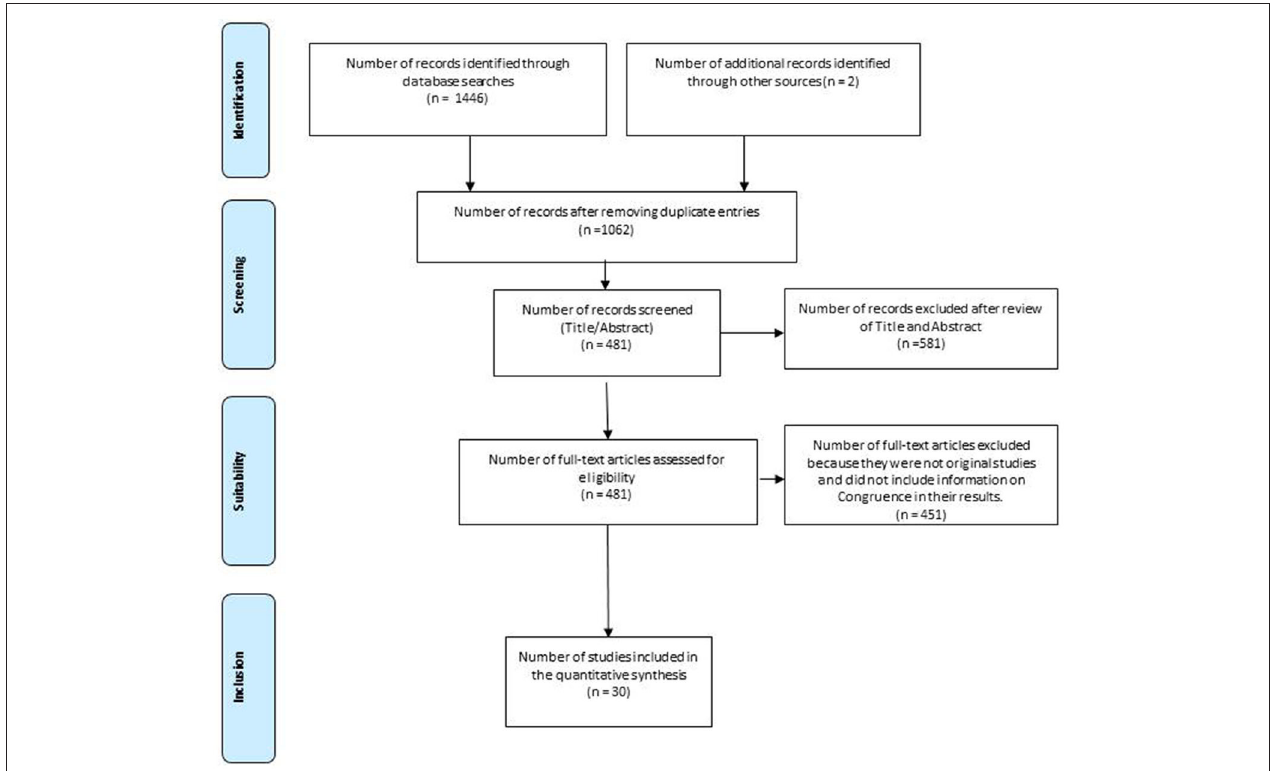
FIGURE 1 | Flow diagram of the selection of studies for the systematic review. Source: Moher et al.